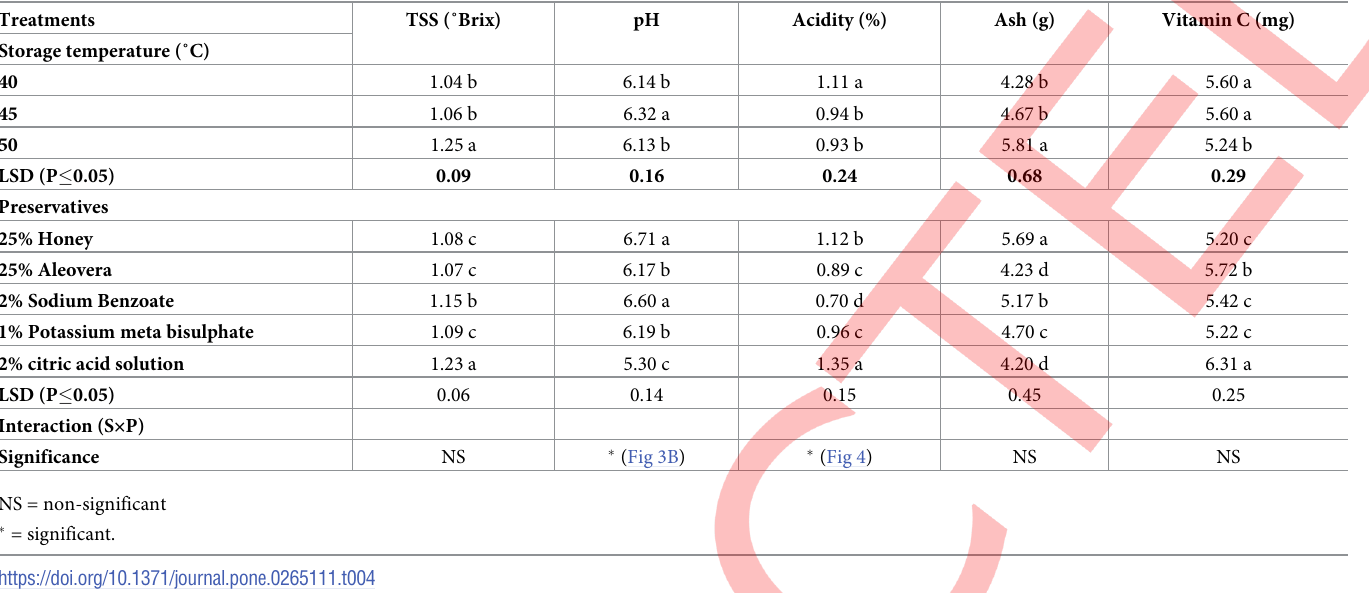
NS = non-significant � = significant.